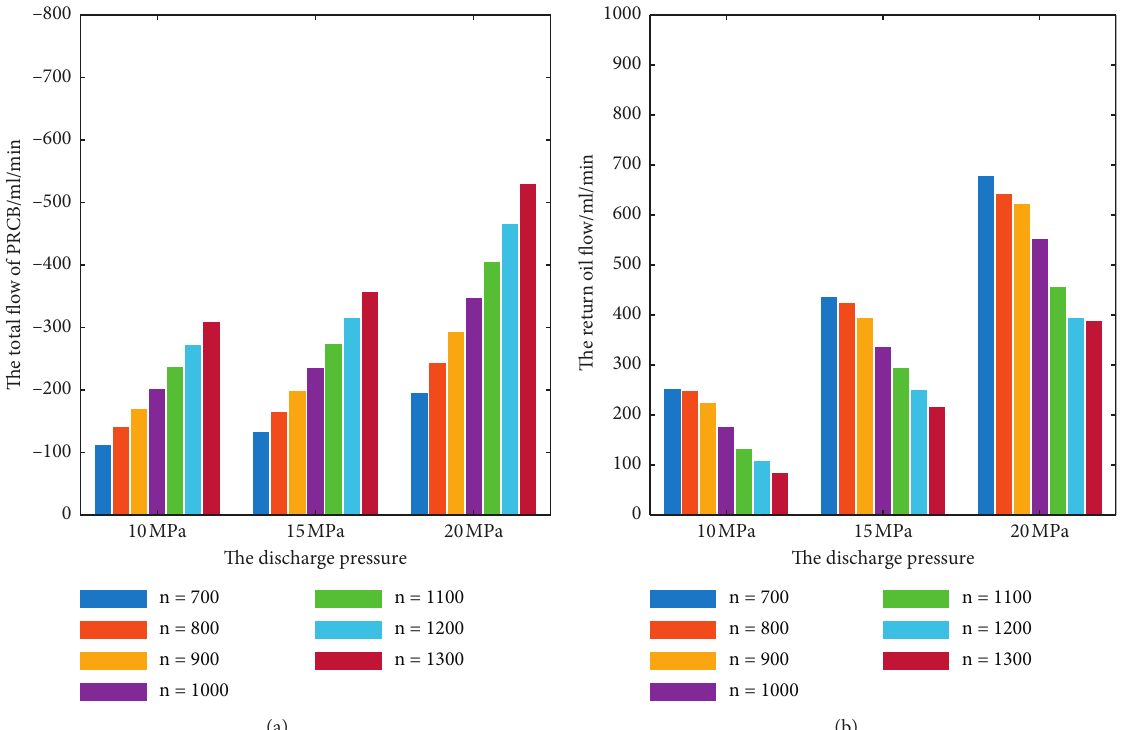
Figure 17: Simulated results and measured results. (a) Simulating the total flow rate of PRCB; (b) measuring the return oil flow rate.